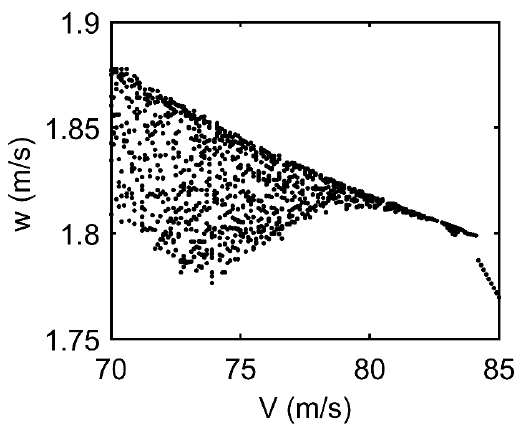
Figure 8. Bifurcation diagram of the delay-free model respecting to forward speed V.